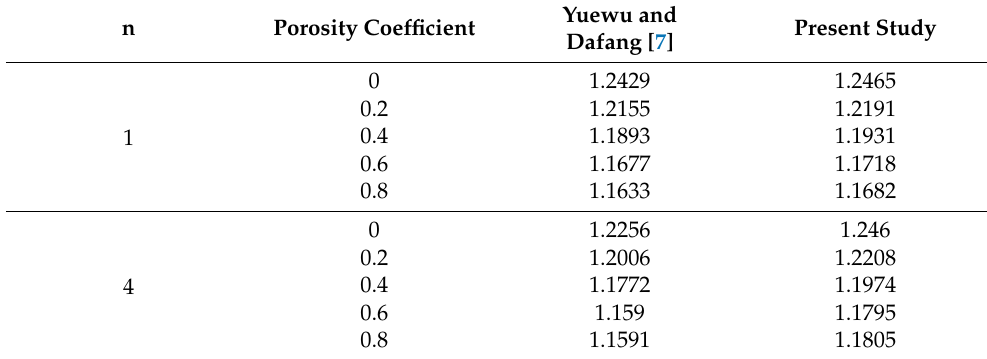
Table 3. Comparison of dimensionless excitation